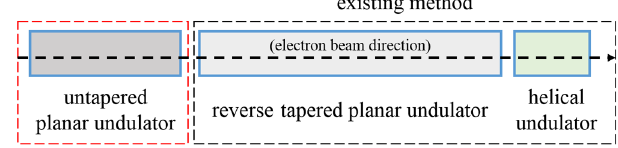
FIG. 1. Conceptual drawing of the modified reverse tapering method (combination of the red box and the black one) and the simple linear reverse tapering method (black box). (Fig. 1, black box): the linearly reverse tapered planar undulator and the helical undulator. In the first stage, the linearly polarized radiation power increase is suppressed, but the bunching factor of the electron beam is still growing, as in the nontapering case. Then the circularly polarized radiation power increases quickly when the microbunched electron beam propagates the helical undulator. This method is quite simple, so it is easily adapted to existing or scheduled undulator lines. In this paper, this simple linear reverse tapering method is called “ the existing method. ”